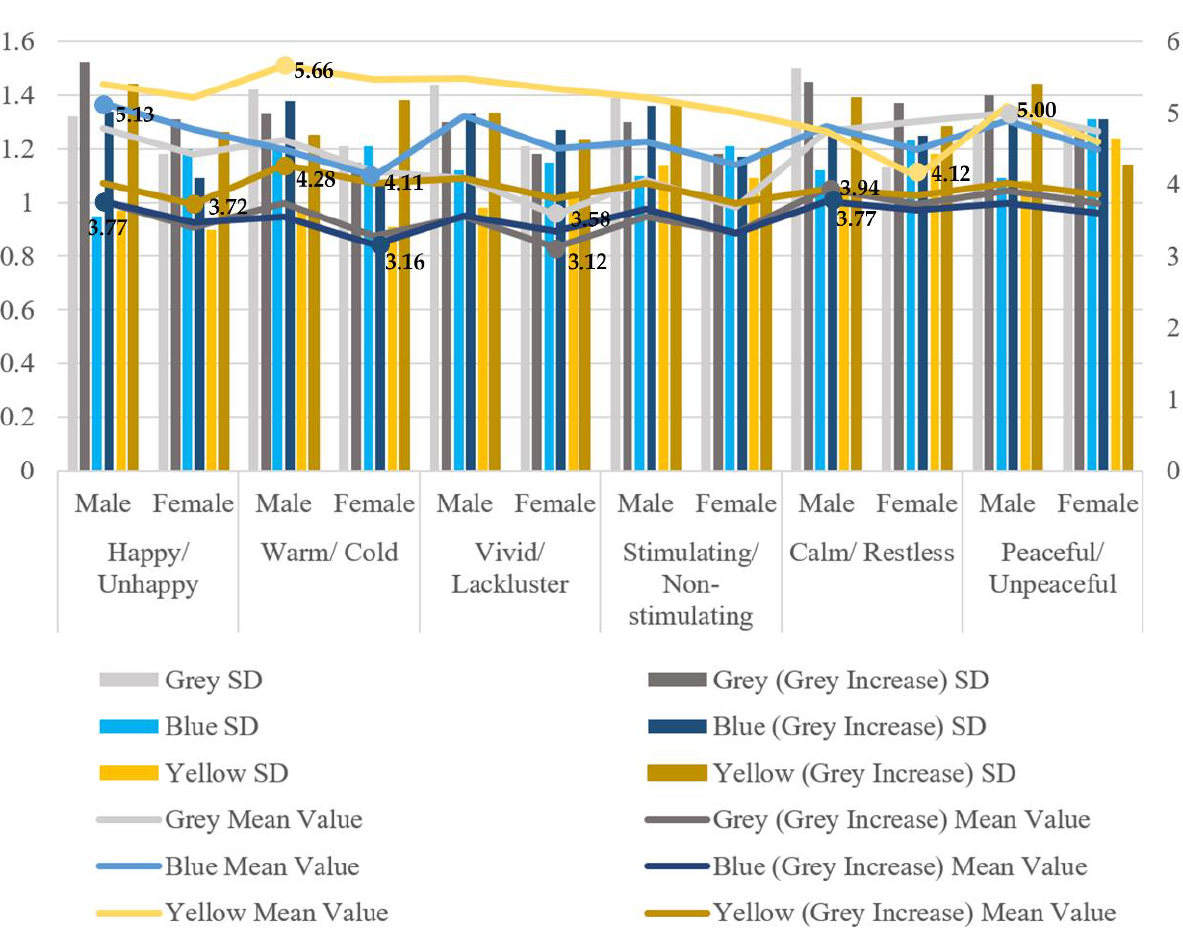
Figure 7. The influence of gender on color perception.